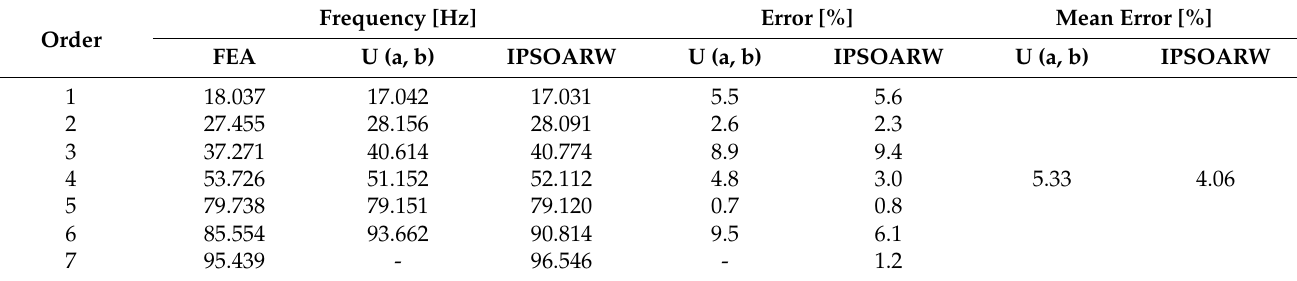
Table 10. Comparison of the frequency of the bridge deck based on two